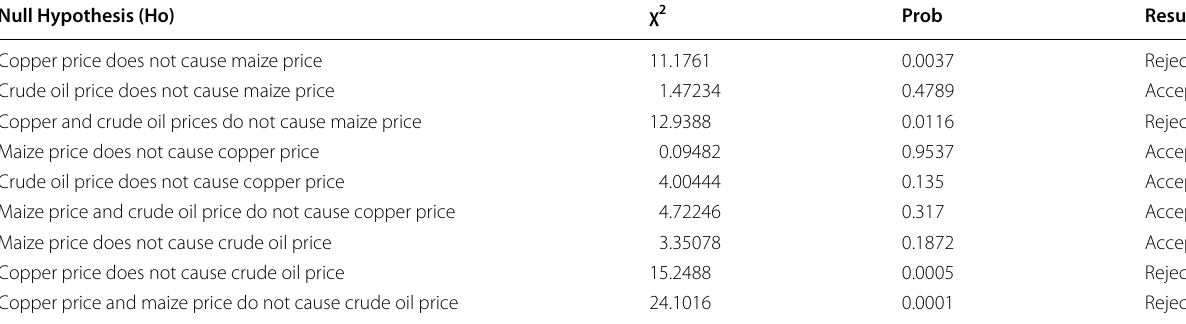
Table 14 Granger Causality (2000 to 2021 data) Null Hypothesis